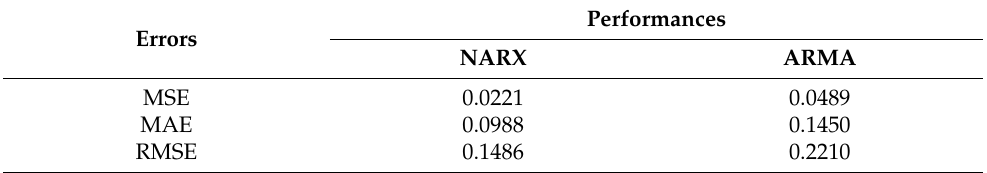
Figure 32. ( a ) Error and ( b ) relative error of the prediction of solar radiation using the NARX model. Table 14. Performance comparison between NARX and ARMA.